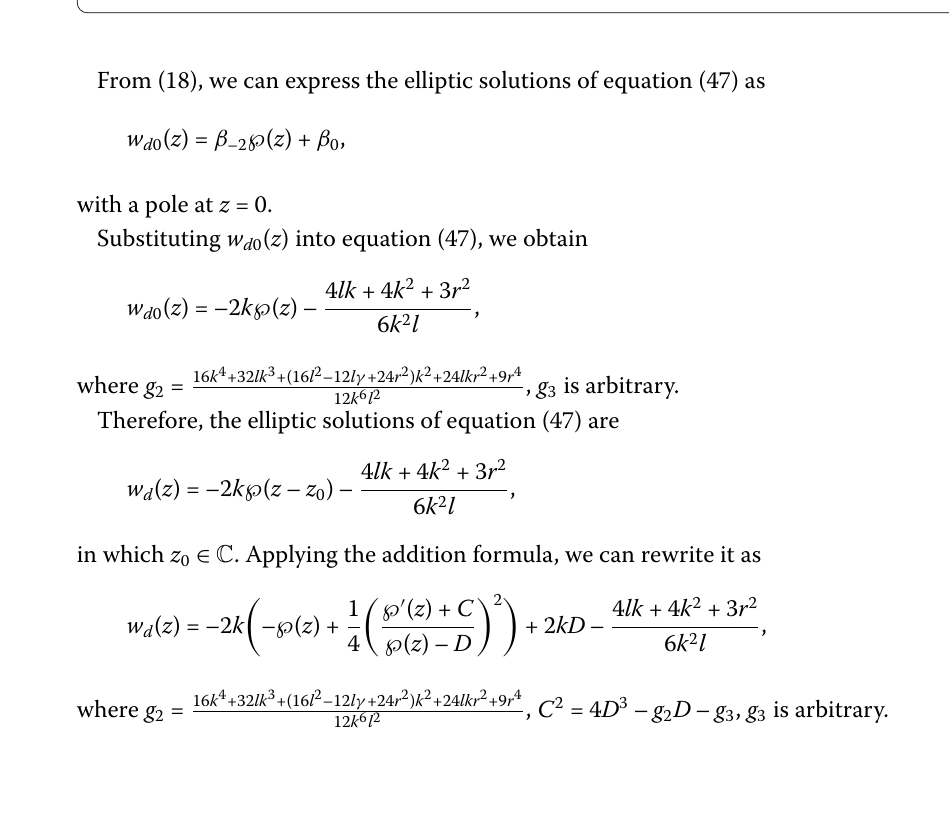
Figure 1 The solution of the gZK equation corresponding to W s ,2 ( z ). (a) z 0 = –8, (b) z 0 = 0, (c) z 0 =